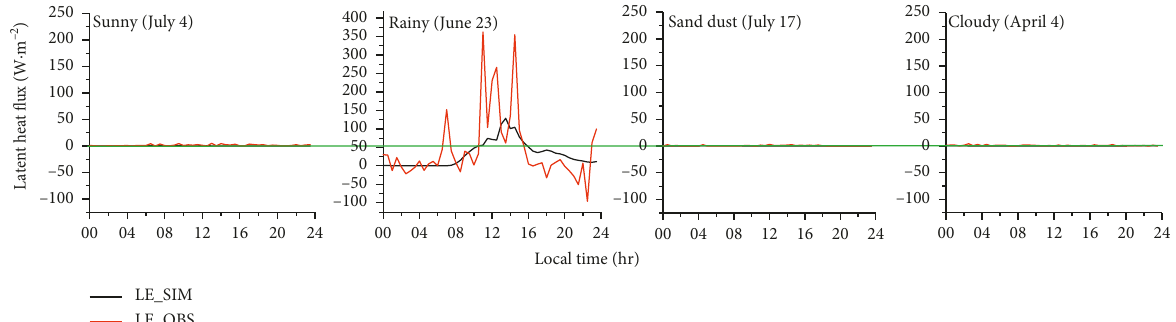
Figure 8: Contrast curve between the simulated (black) and observed (red) LE for the four types of weather at the Tazhong station in 2014.